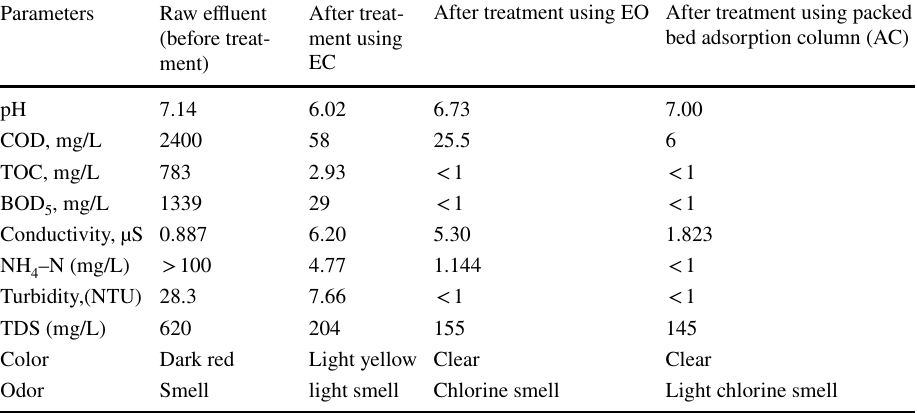
Parameters Raw effluent